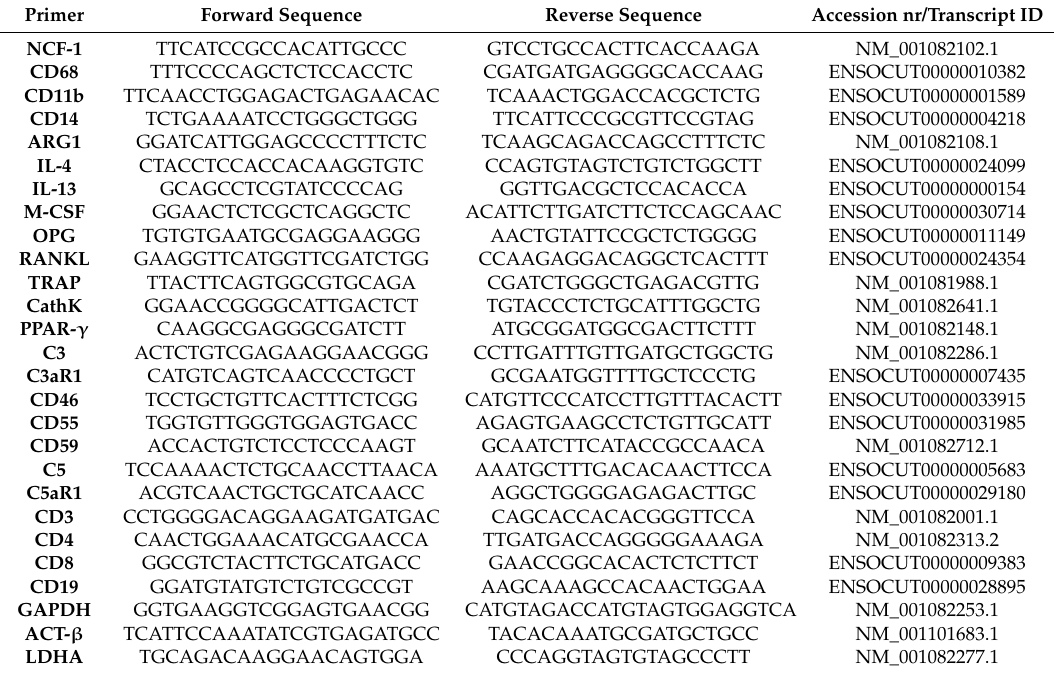
Table 1. Gene sequences.